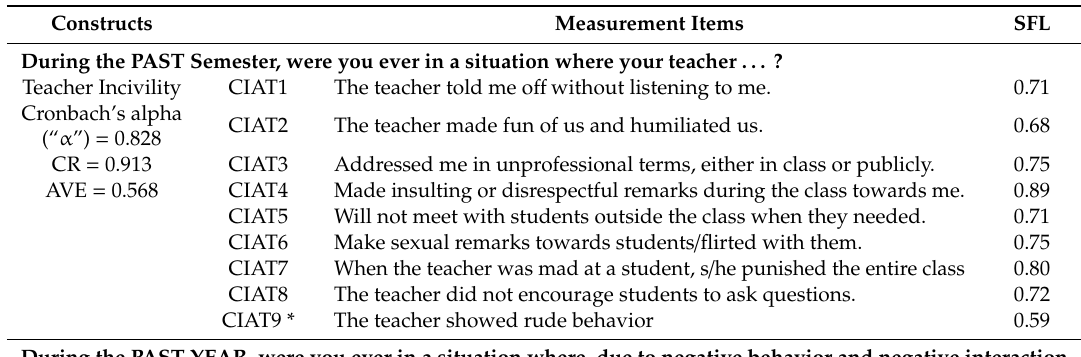
Table 3. Confirmatory factor analysis, students’ perspective.